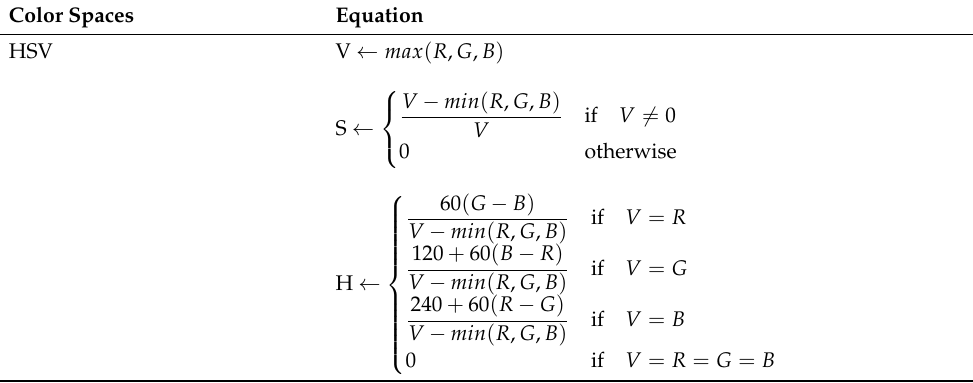
Table A1. Usual color spaces computed from RGB